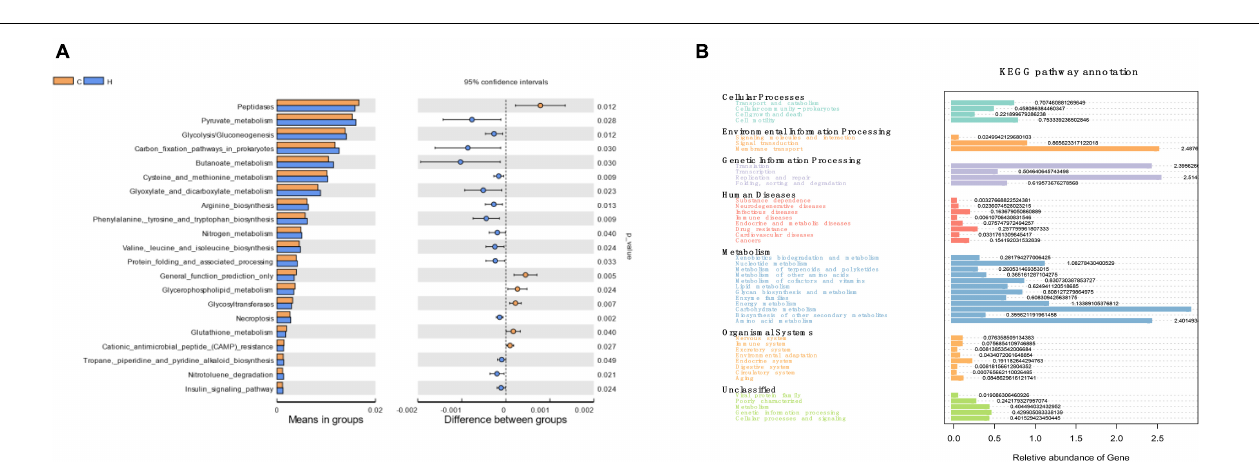
FIGURE 3 | Effect of HS on the rabbit fecal microorganisms. (A) Histogram of species relative abundance at the phylum level; (B) phylogenetic relationship of the species at the genus level. (C) Histogram of the species’ relative abundance at the genus level; (D) different species at the genus level in the HS and CON groups. (E) Dendrogram depicting the flora expression.